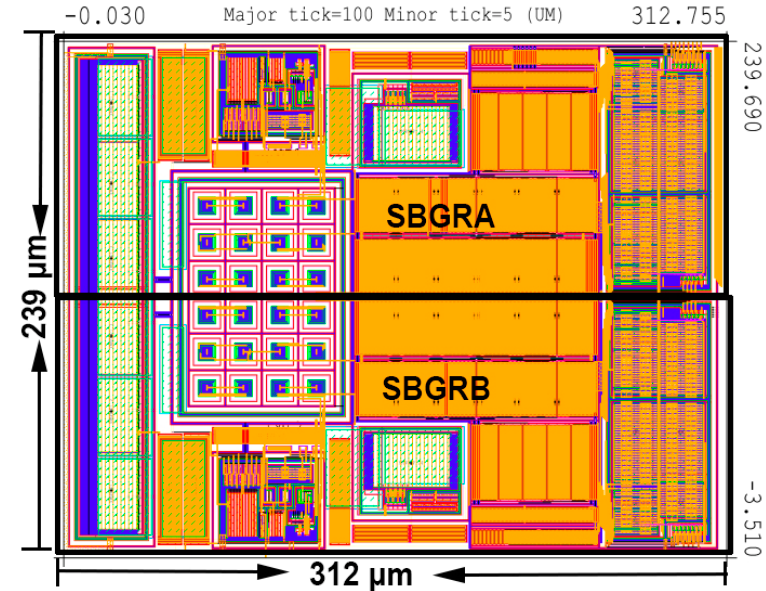
Figure 9. Layout of proposed SPWBGR.